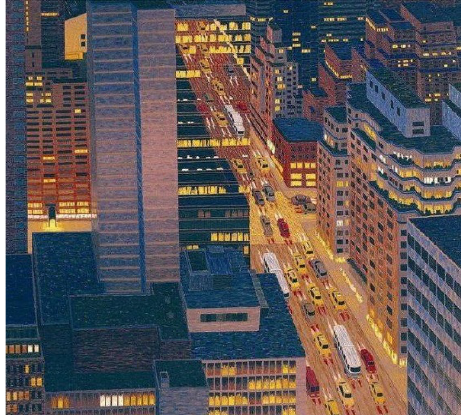
Fig. 22 Third Avenue (with reflection) III, 2005 Fig. 23 Empire State Building II, 2009. Oil on